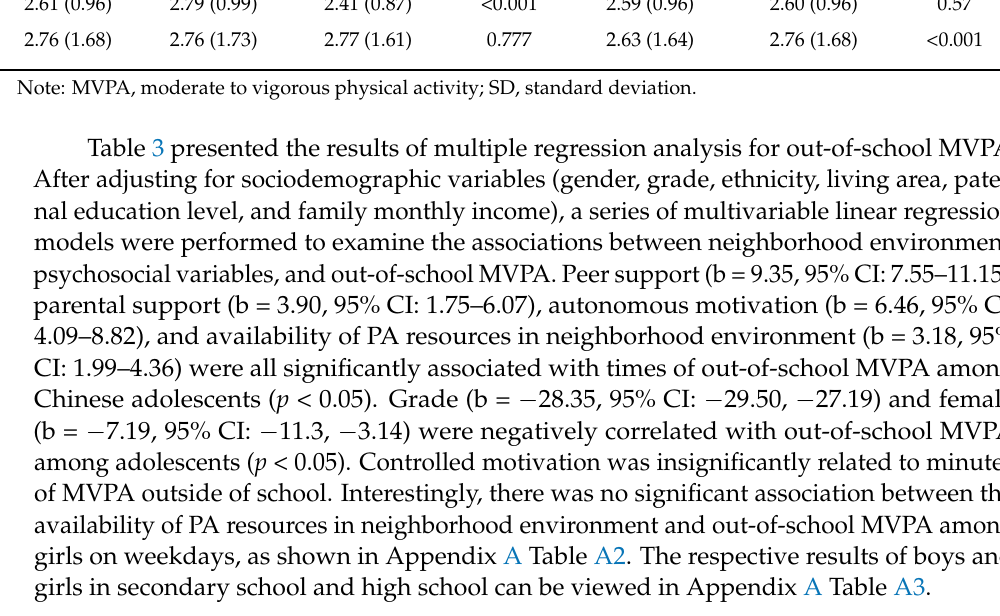
Table 3. Multiple regression analysis for out-of-school MVPA among adolescents.